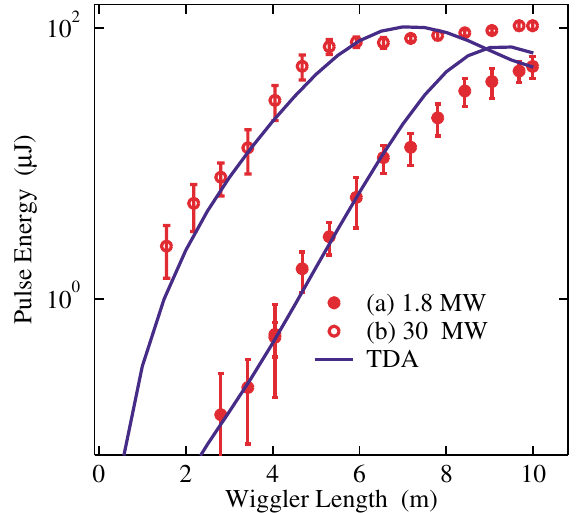
FIG. 7. (Color) Pulse energy vs distance for two values of the input seed laser power: (a) 1.8 MWand (b) 30 MW. The red dots are measurements and the solid curves are TDA simulation